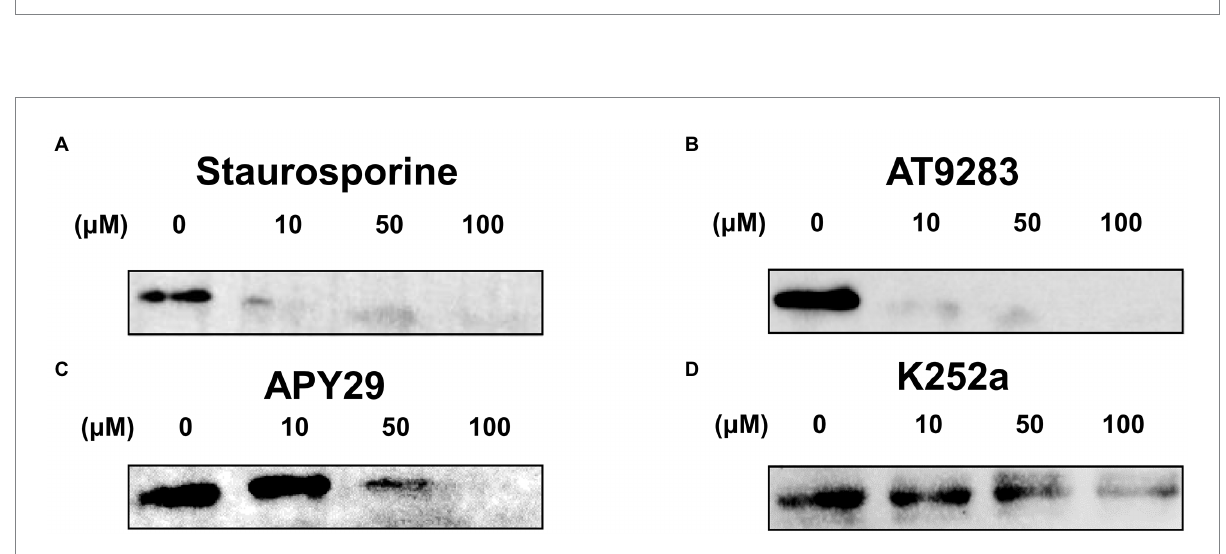
FIGURE 3 Screening of ssSTK inhibitors. (A) The scatter plot of the primary screening with the 1,133 compounds; (B–E) The structure of Staurosporine, APY29, AT9283, and K252a, respectively.